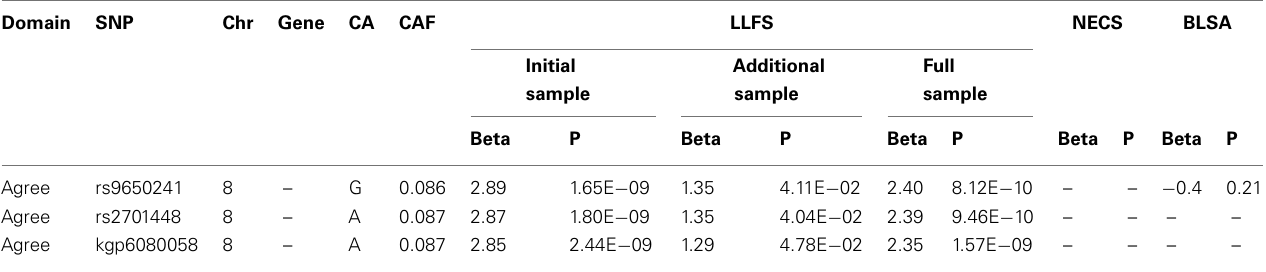
Table 2 | Genome-wide significant SNPs in the GWAS of